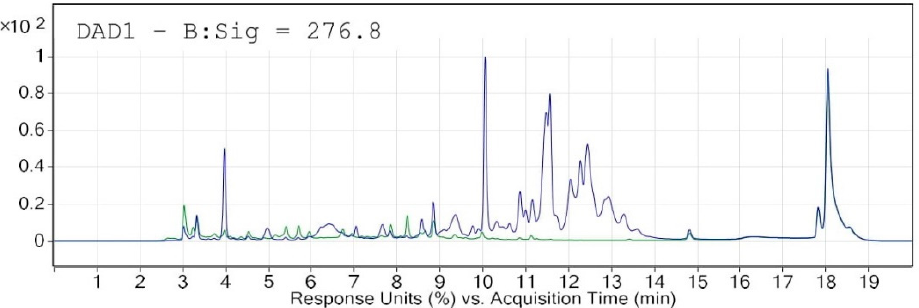
Figure 5. List of chromatograms obtained during the HPLC-DAD analysis for C. quercusfolii gall nut samples, green, and A. infectorius , blue.